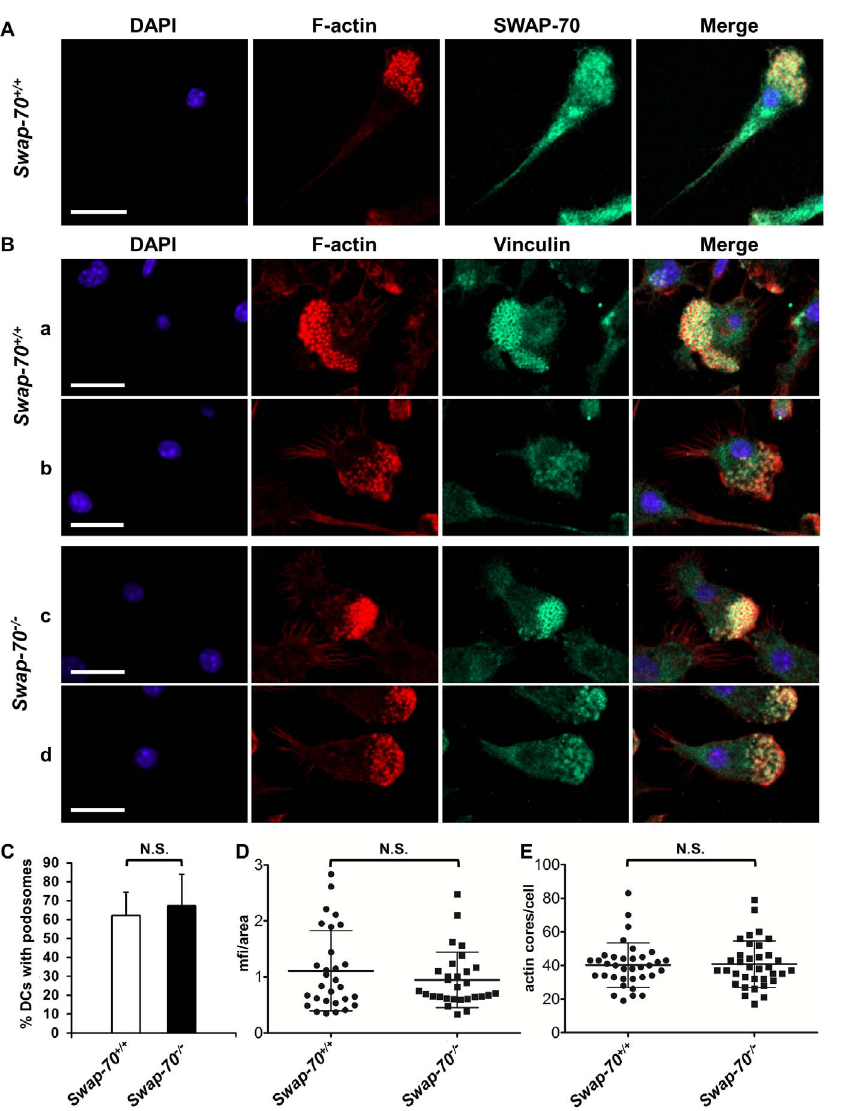
Figure 1. SWAP-70 localizes to podosome clusters but podosome formation is not affected by SWAP-70 deficiency in DCs. ( A ) Swap- 70 + / + DCs were stained with anti-SWAP-70 (green), rhodamine phalloidin for F-actin (red), and DAPI for the nucleus (blue) and analyzed with confocal laser scanning microscopy. Representative picture is shown. ( B ) Confocal immunofluorescence microscopy analysis of two individual Swap-70 + / + ( a , b ) and Swap-70 –/– ( c , d ) DCs. DCs were seeded and incubated for at least 2 h and stained with anti-Vinculin (green), rhodamine phalloidin for F-actin (red), and DAPI for the nucleus (blue). ( C ) Quantification of the number of DCs exhibiting podosome clusters. . 100 cells were analyzed per genotype and experiment. Mean values of 4 independent experiments with error bars indicating + SD are shown. ( D ) Quantification of the mean fluorescence intensity (mfi) per area of podosome structures by measuring fluorescence intensity of rhodamine phalloidin staining (F-actin). Mean values of 30 individual cells per genotype of 2 independent experiments with error bars indicating 6 SD are shown. ( E ) Quantification of the number of podosome actin cores per cell. Mean values of 35 individual cells per genotype of 2 independent experiments with error bars indicating 6 SD are shown. N.S. denotes not significant. Scale bars, 20 m